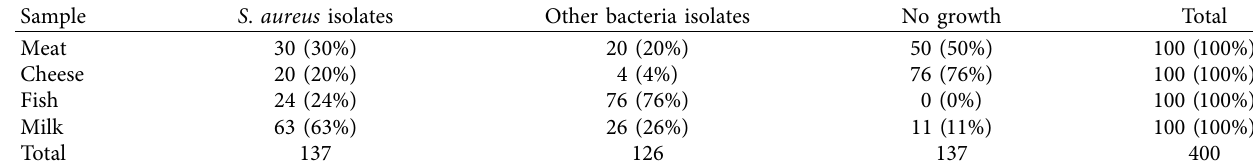
Table 5: Distribution of Staphylococcus aureus isolates according to the type of food samples.